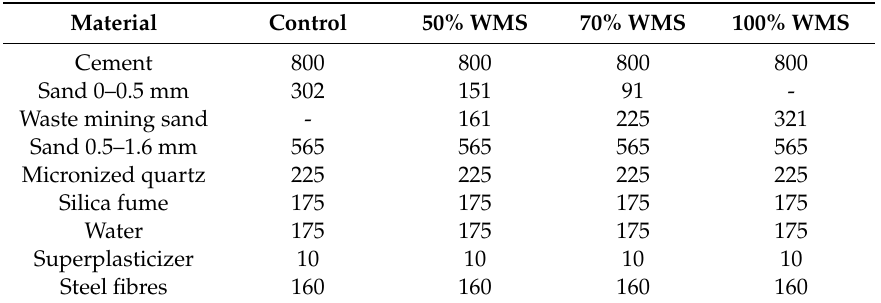
Table 3. Dosages of Ultra High Performance Fibre Reinforced Concrete (UHPFRC) (kg / m 3